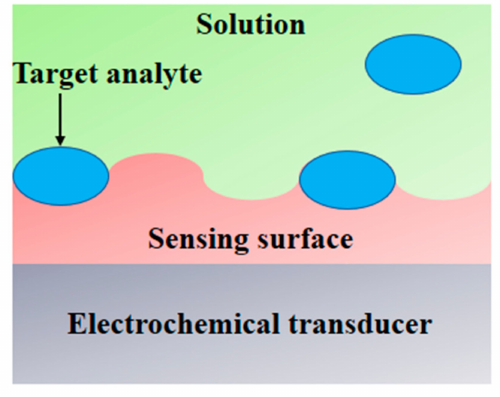
Figure 7. A schematic of an electrochemical